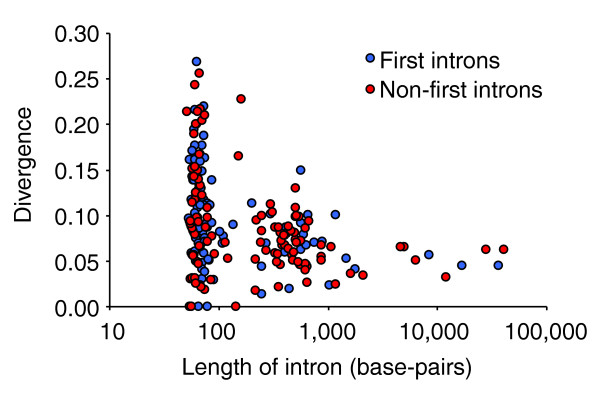
The relationship between intron length and the level of divergence between D. melanogaster and D. simulans for the combined dataset of 225 introns. A significantly negative correlation is found for all introns (Spearman correlation coefficient Rs = -0.388, P < 10-4), first introns (Rs = -0.451, P < 10-4) and non-first introns (Rs = -0.304, P < 10-4).